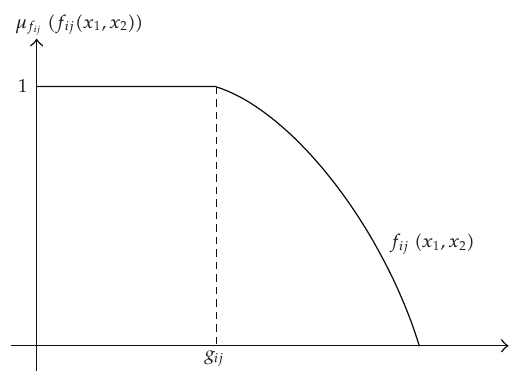
Figure 1: Membership function of minimization-type objective